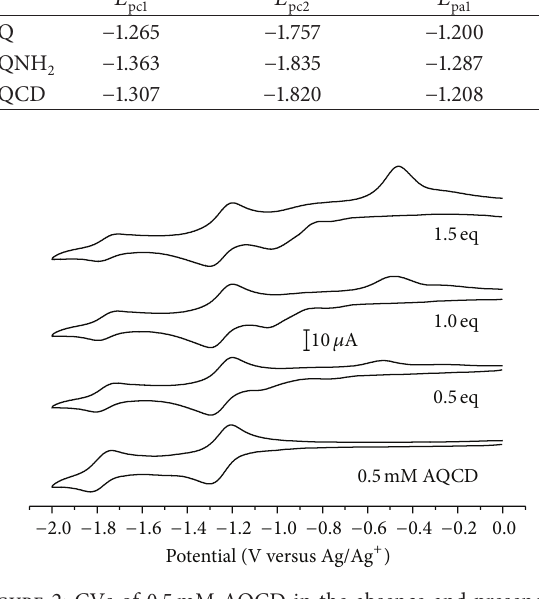
Figure 3: CVs of 0.75 mM Cu 2+ in the absence and the presence of 0.5 mM AQ, AQNH 2 , and AQCD in 0.1M TBAPF 6 /CH 3 CN. Scan rate: